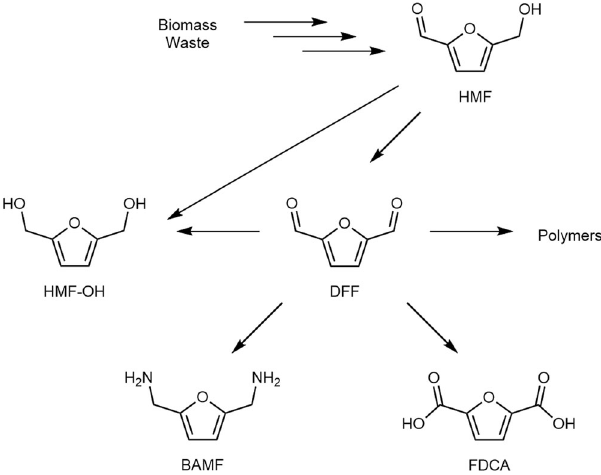
Fig. 1 Diversi fi cation of HMF to high value products via DFF intermediate. Bio-derived HMF can be chemically and/or enzymatically converted to various other furans that are useful as intermediates or monomers. HMF, 5- (hydroxymethyl)furfural. DFF, 2,5-diformylfuran. HMF-OH, 2,5-bis (hydroxymethyl)furan. BAMF, 2,5-bis(aminomethyl)furan. FDCA, 2,5- furandicarboxylic